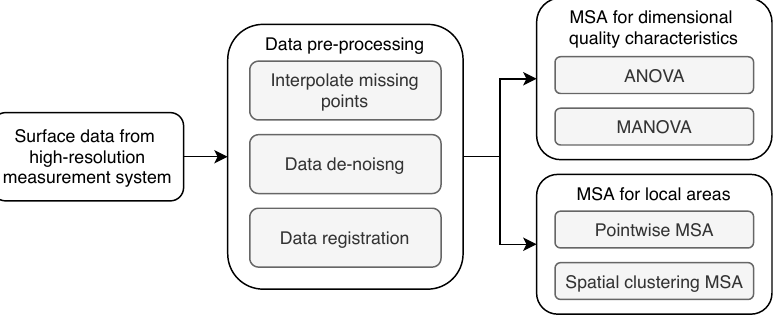
Figure 3. A typical MSA procedure for 3D surface